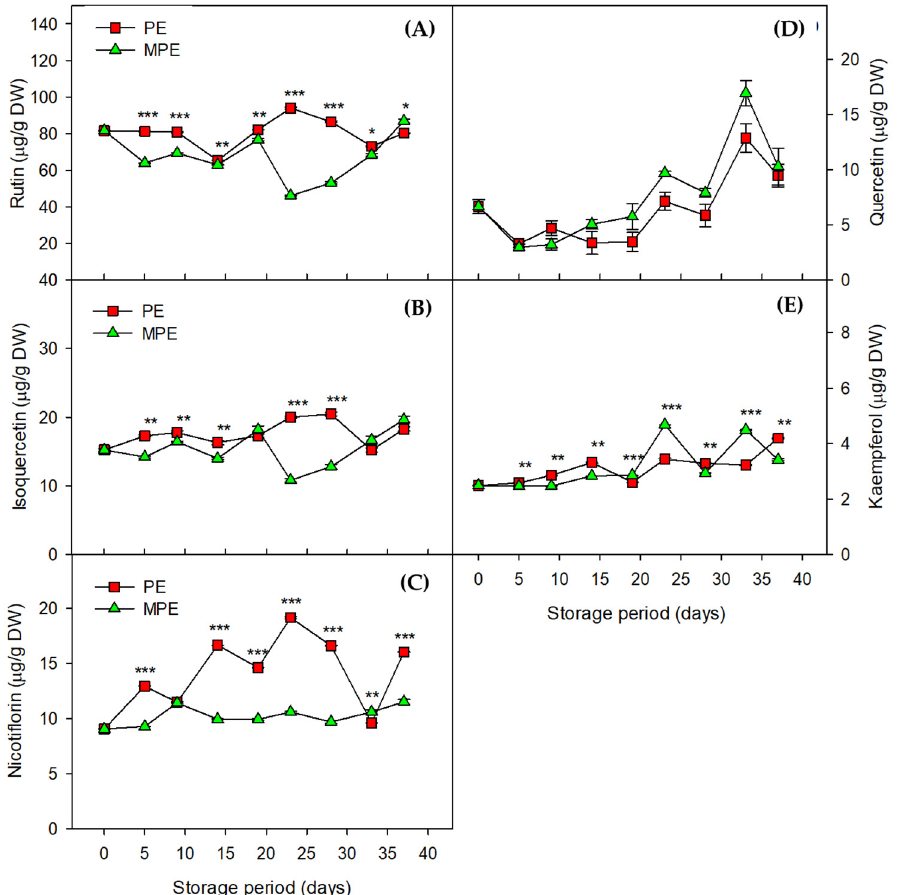
Figure 6. Changes in the flavonoids of G. littoralis during storage at 4 °C. ( A ), rutin; ( B ), isoquercetin; ( C ), nicotiflorin; ( D ), quercetin; and ( E ), kaempferol. MAP treatment was classified into micro-per- forated PE (MPE, 32 pinholes) and PE on the basis of the presence or absence of pinholes, respec- tively. Values are shown as mean ± standard deviation. Statistical significance was shown by a t - test between PE and MPE at each time point during storage (*** p < 0.001, ** p < 0.01, and * p < 0.05).